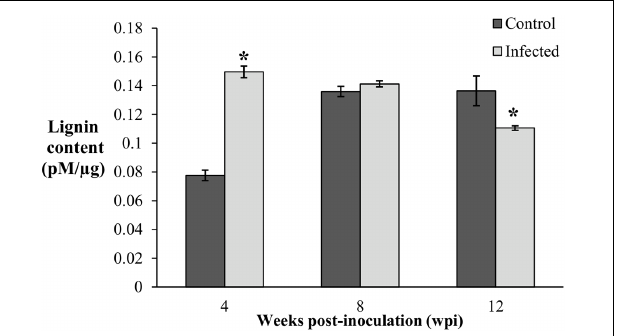
FIGURE 3 | Lignin content in root tissues of the control (non-inoculated) and infected, Ganoderma boninense challenged oil palm seedlings at 4, 8, and 12 wpi. Disease severity (DS) of the infected seedlings at 4, 8, and 12 wpi was 5, 34, and 69%, respectively. Bars represent the mean ± standard deviation of four biological replicates. Asterisk indicates significant difference at p < 0.05.